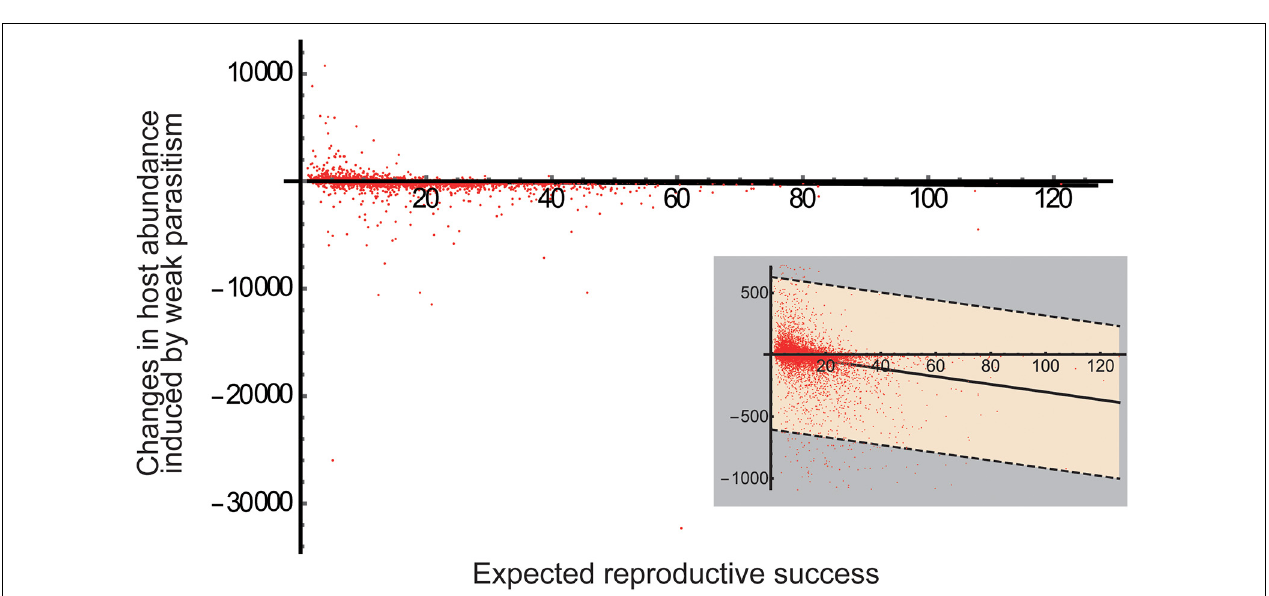
FIGURE 5 | Linear correlation between weak parasitism-induced changes in host abundance and expected reproductive success. The horizontal axis represents the expected reproductive success at the steady state in the absence of juvenile-specific parasitism (a PJ = 0). The vertical axis represents a difference in the total host abundance in the presence and absence of weak parasitism (a PJ = 0.001) at the steady state. The red dots indicate the results of ca. 75% of 50,000 simulations that met the assumption that adult-specific mutualism was net beneficial for both the adult host and partner species (i.e., b A a A -a PA > 0 and b PA a PA -a A > 0). The small panel provides an enlarged view of the results. The solid and dashed lines indicate the predicted regressions and 95% confidence intervals, respectively. Other parameter values are the same as in Figure 3 .